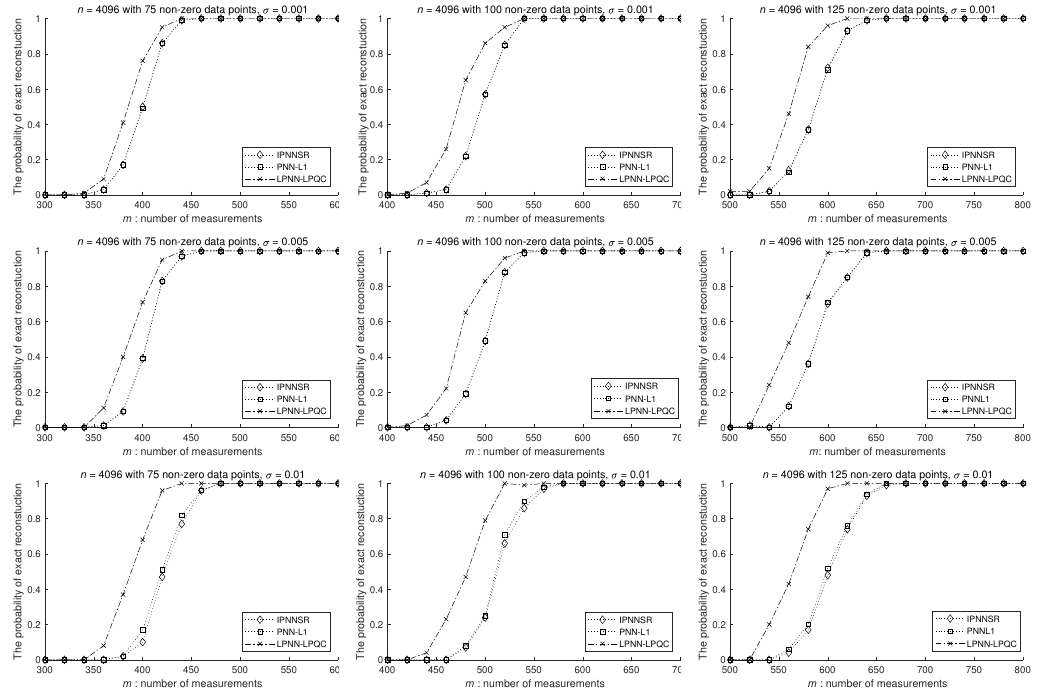
Figure 8. Comparison with other analog models on probability of reconstruction, where n = 4096. For the first column, k = 75. For the second column, k = 100. For the third column, k = 125. The three rows are based on three different noise levels. The experiments are repeated 100 times using different